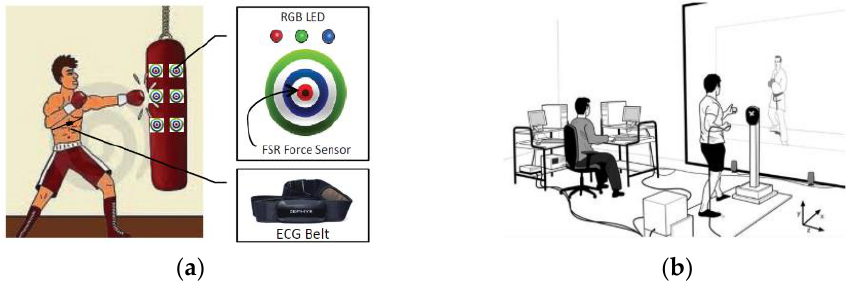
Figure 5. ( a ) Box bag and ECG belt system assembly. ( b ) Pictorial representation of the experimental set.